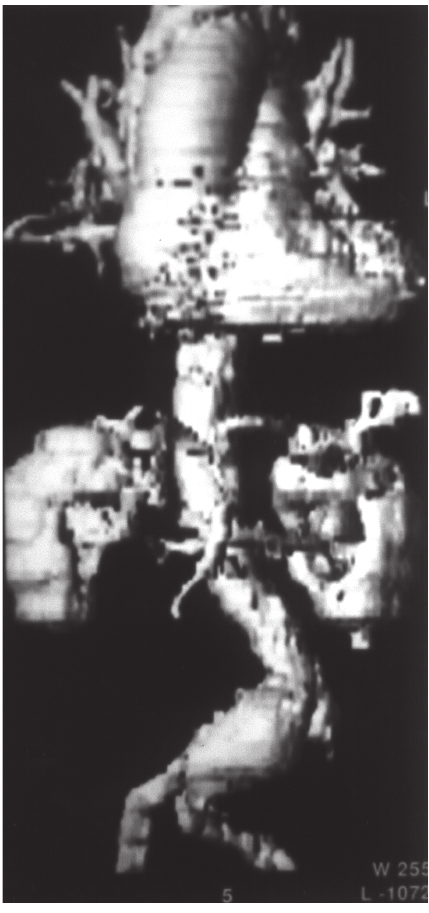
Figure 5 - Helical computerized tomography imaging: 3-D reconstruction of the abdominal